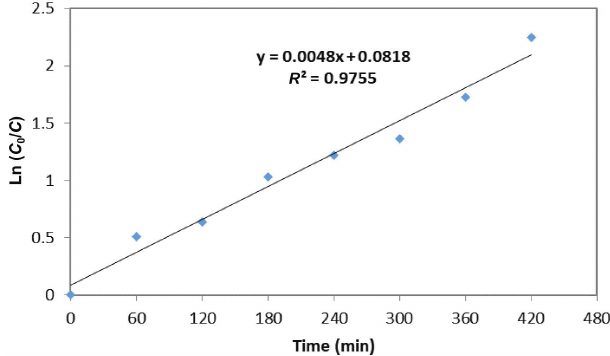
Fig. 6 – Pseudo first-order kinetic analysis of PPc process for high salinity petrochemical wastewater (pH = 4, voltage: 1.5 V, electrode distance: 2 cm, reaction time: 240 min)